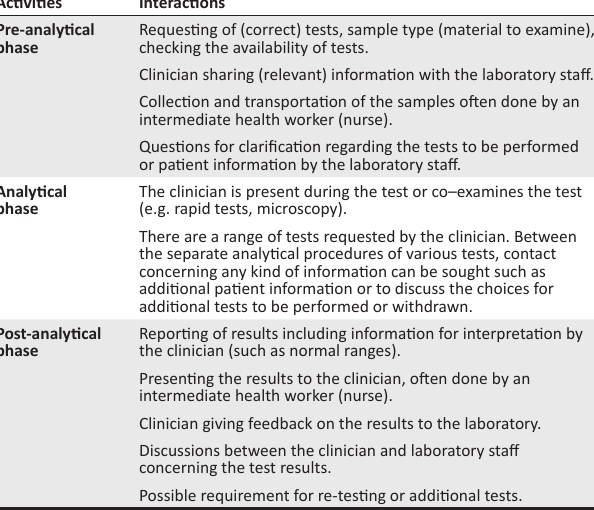
TABLE 2: Activities and interactions taking place between clinicians and laboratory staff during the pre-analytical, analytical and the post-analytical